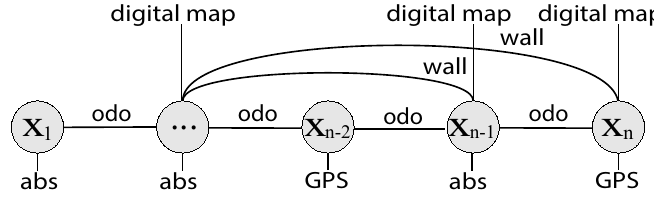
Figure 3. Depiction of the pose-graph SLAM factors. Odometry constraints (odo) are sequential whereas wall loop constraints (wall) can be non-sequential. Absolute constraints (abs) includes digital map correction and altimeter. GPS factors may occur irregularly. When wall is created, we also provide a digital map correction